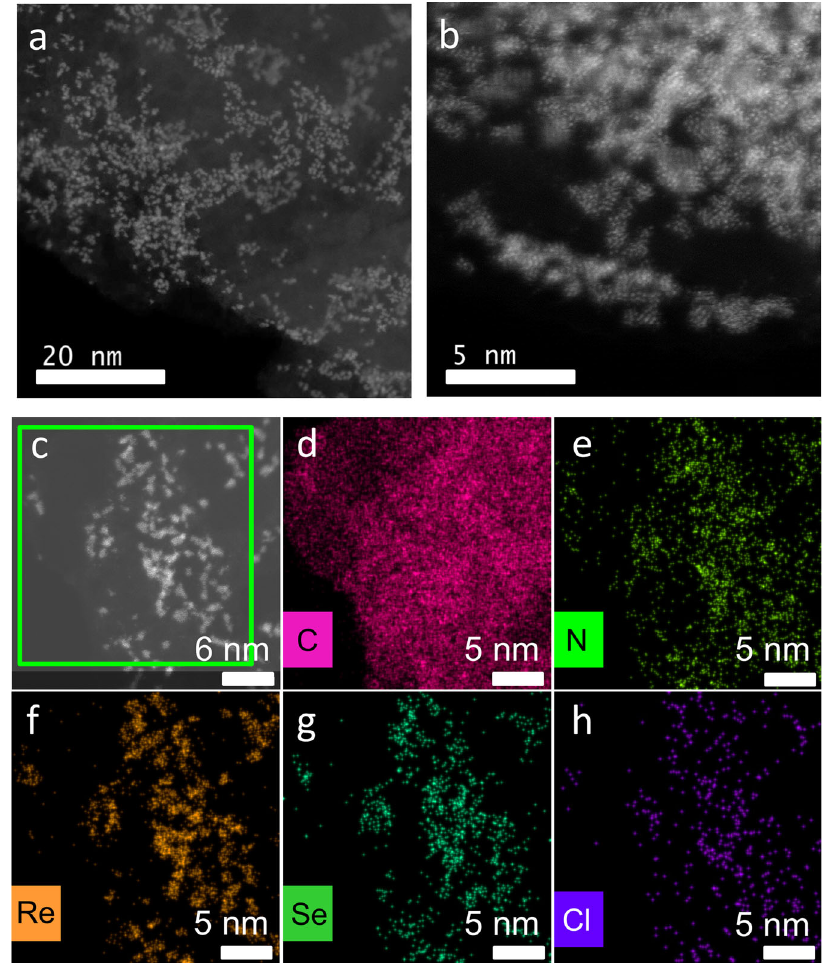
Fig. 6 HAADF STEM images of the clusters-coated graphene ( a , b ) and EDX mapping of a coated region, showing the overlapped position of the clusters as seen by STEM ( c ) and the carbon ( d ), nitrogen ( e ), rhenium ( f ), selenium ( g ) and chlorine ( h )